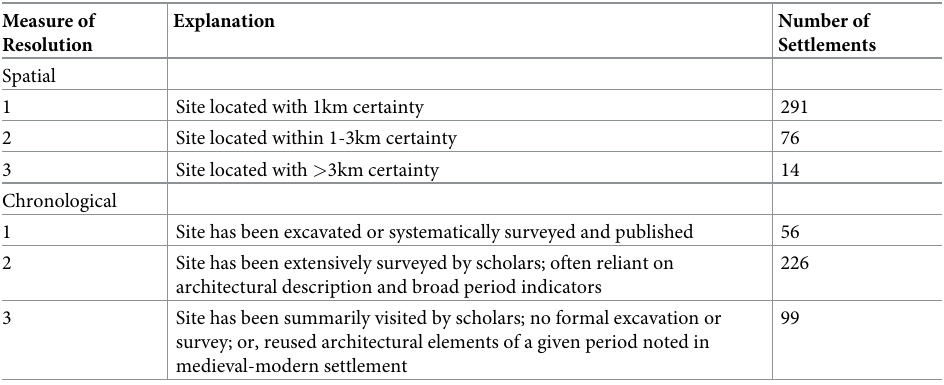
Table 3. Measures of resolution. These are visually presented in S1